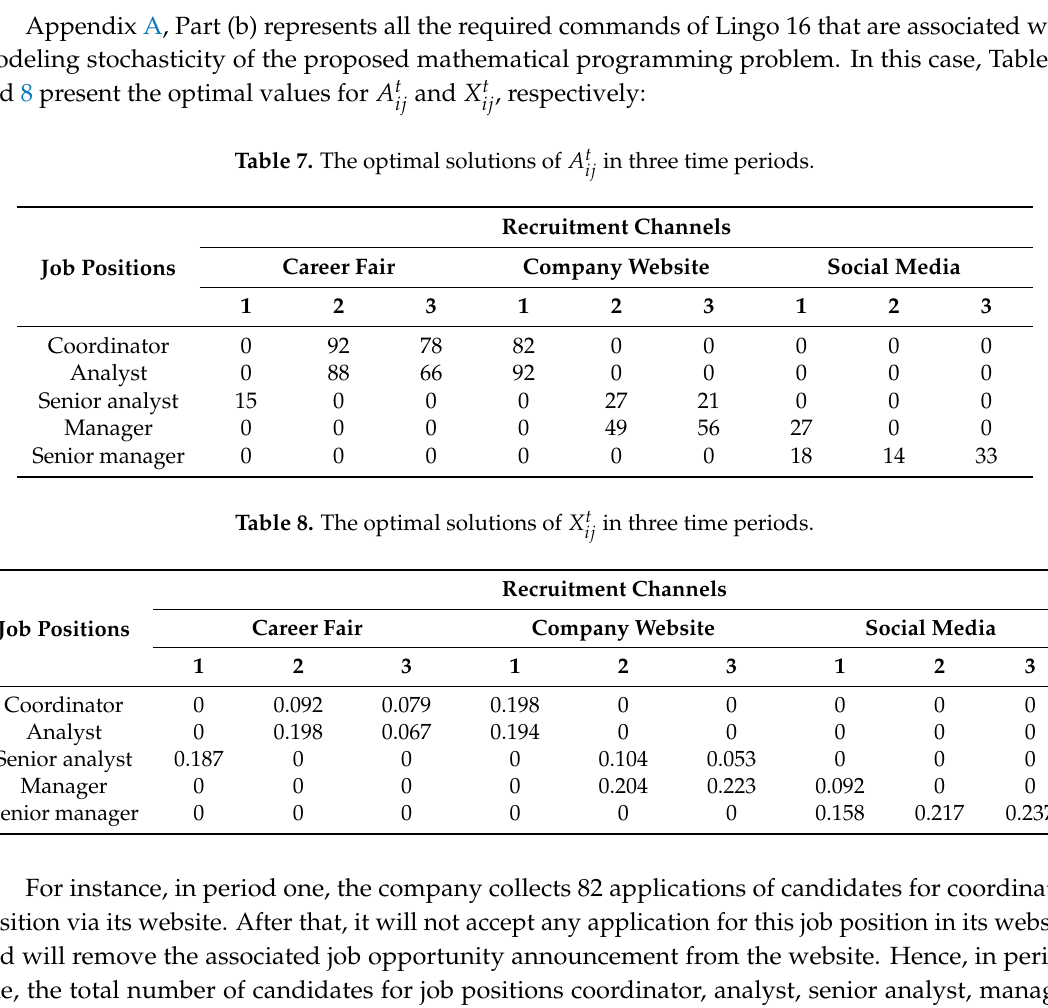
Table 7. The optimal solutions of A t